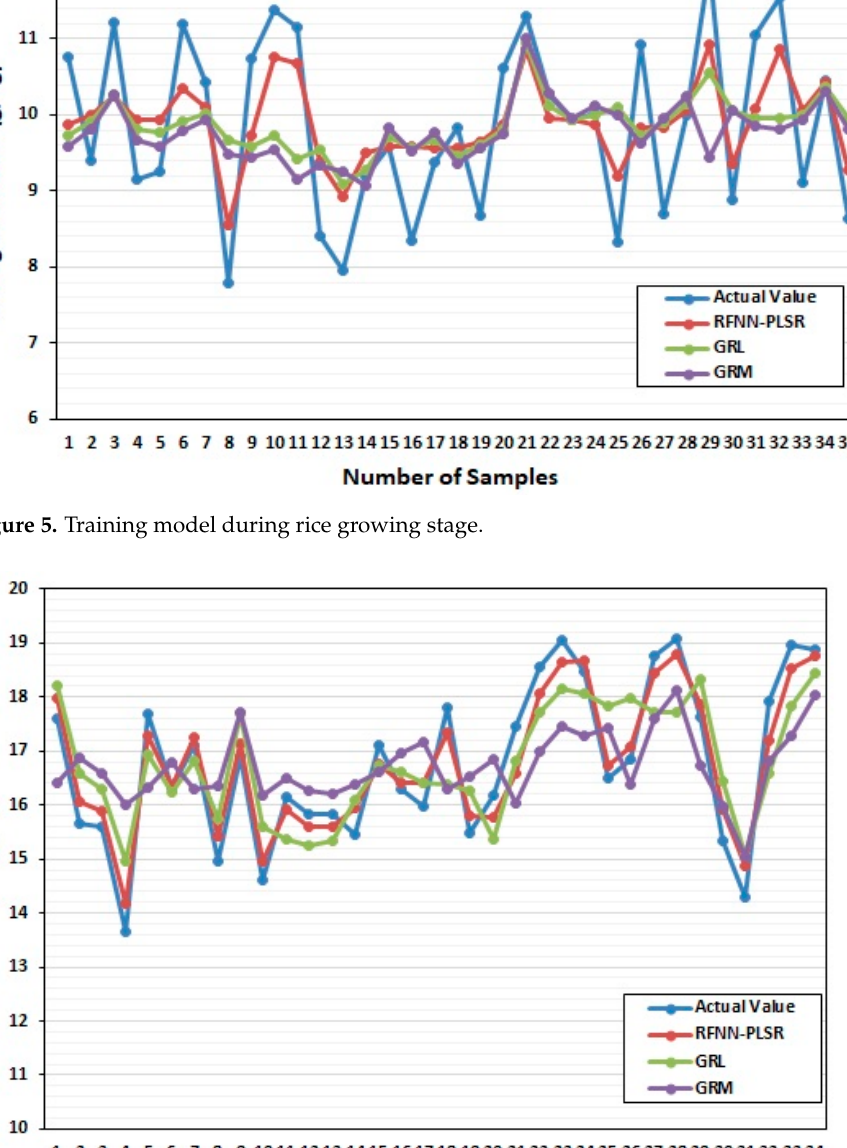
Figure 6. Training model at the maturity stage.